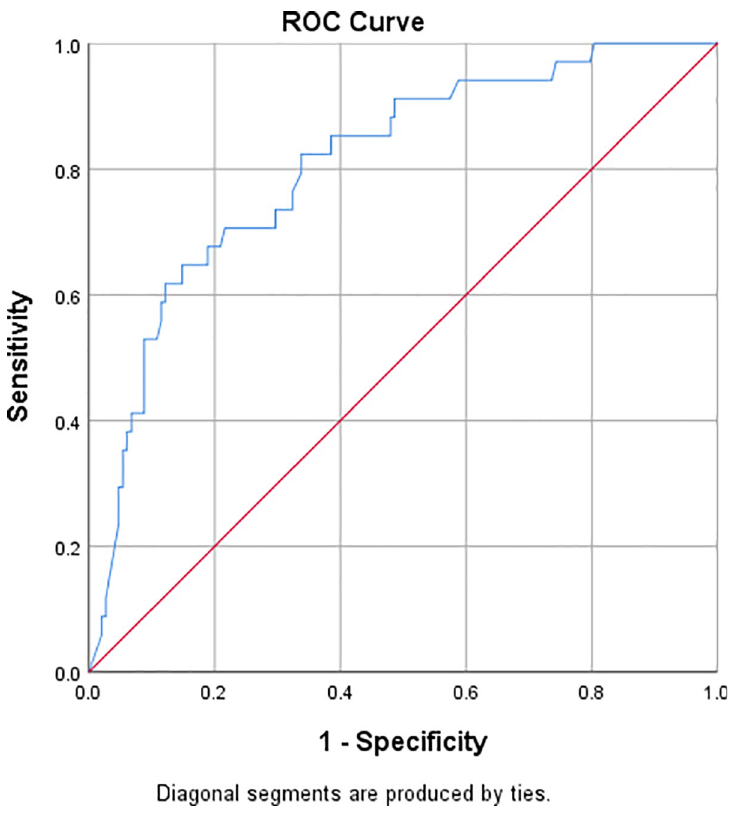
Fig 1. ROC curve for D-dimer as a predictor of in-hospital